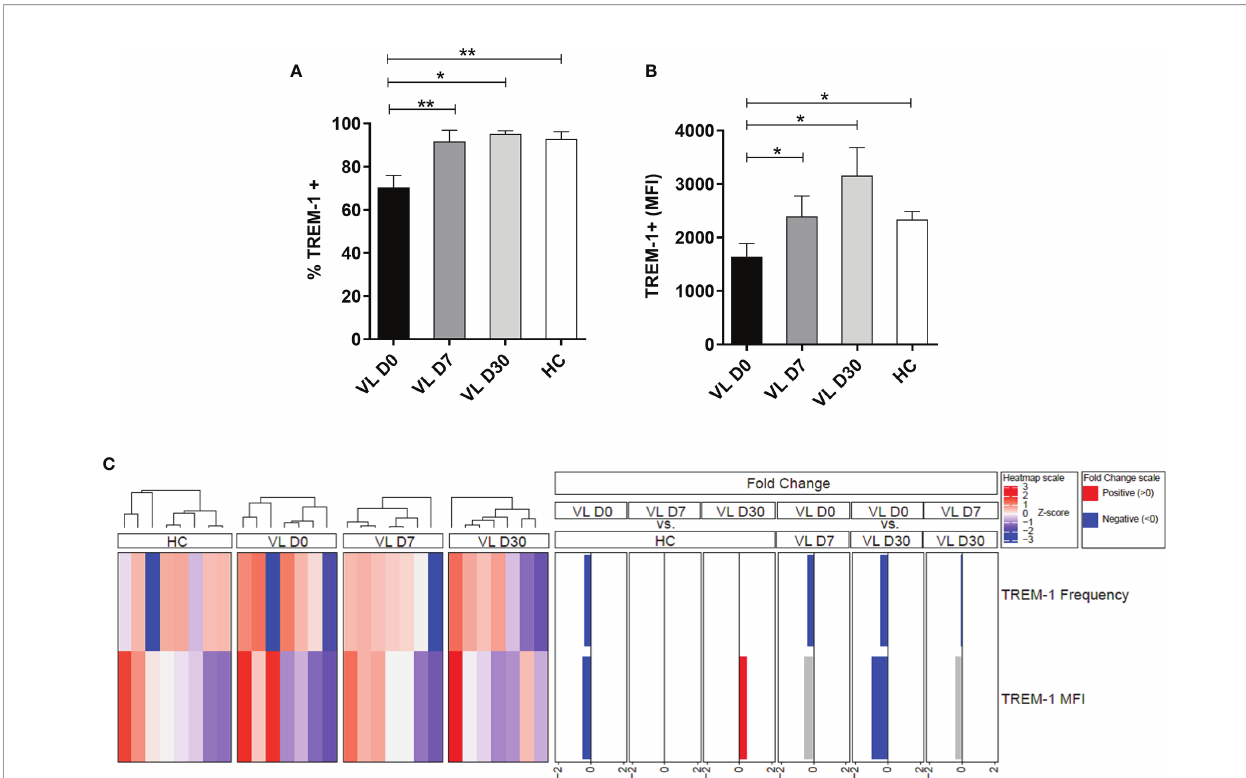
FIGURE 1 | Expression of surface TREM-1 in neutrophils from visceral leishmaniasis (VL) patients at different times of leishmanicidal treatment and healthy controls (HCs). Neutrophils from patients with VL (n = 8) and healthy donors (n = 8) were isolated from the peripheral blood, and (A) the frequency and (B) MFI of neutrophils expressing TREM-1 were assessed by fl ow cytometry. Bars represent the mean ± SEM. Mann – Whitney test or Student ’ s t test were used to compare patients ’ treatment times (VL D0, VL D7, and VL 30) with the HC, and the Friedman test with Dunn ’ s posttest or one-way ANOVA were used for paired analysis of patients in treatment times (VL D0, VL D7, and VL D30). *p < 0.05; **p < 0.01. (C) Cluster analysis and heatmap expressing the frequency and MFI of TREM-1 in the neutrophils of patients with VL at different times of treatment and in HCs. Fold changes were calculated, and statistically signi fi cant differences are highlighted in blue and red.